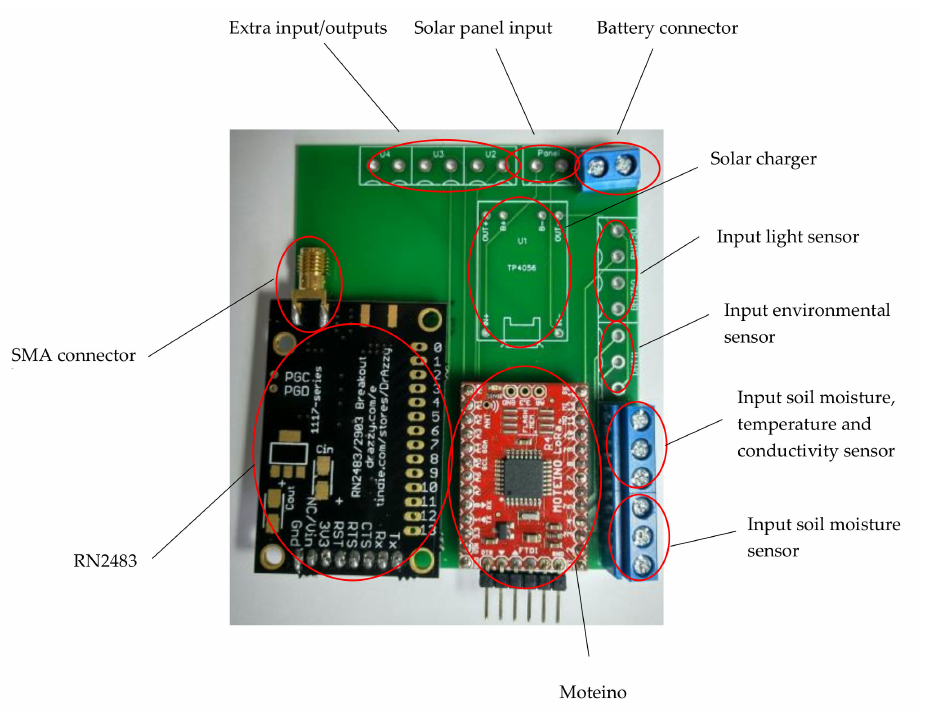
Figure 1. Photograph of the wireless sensor